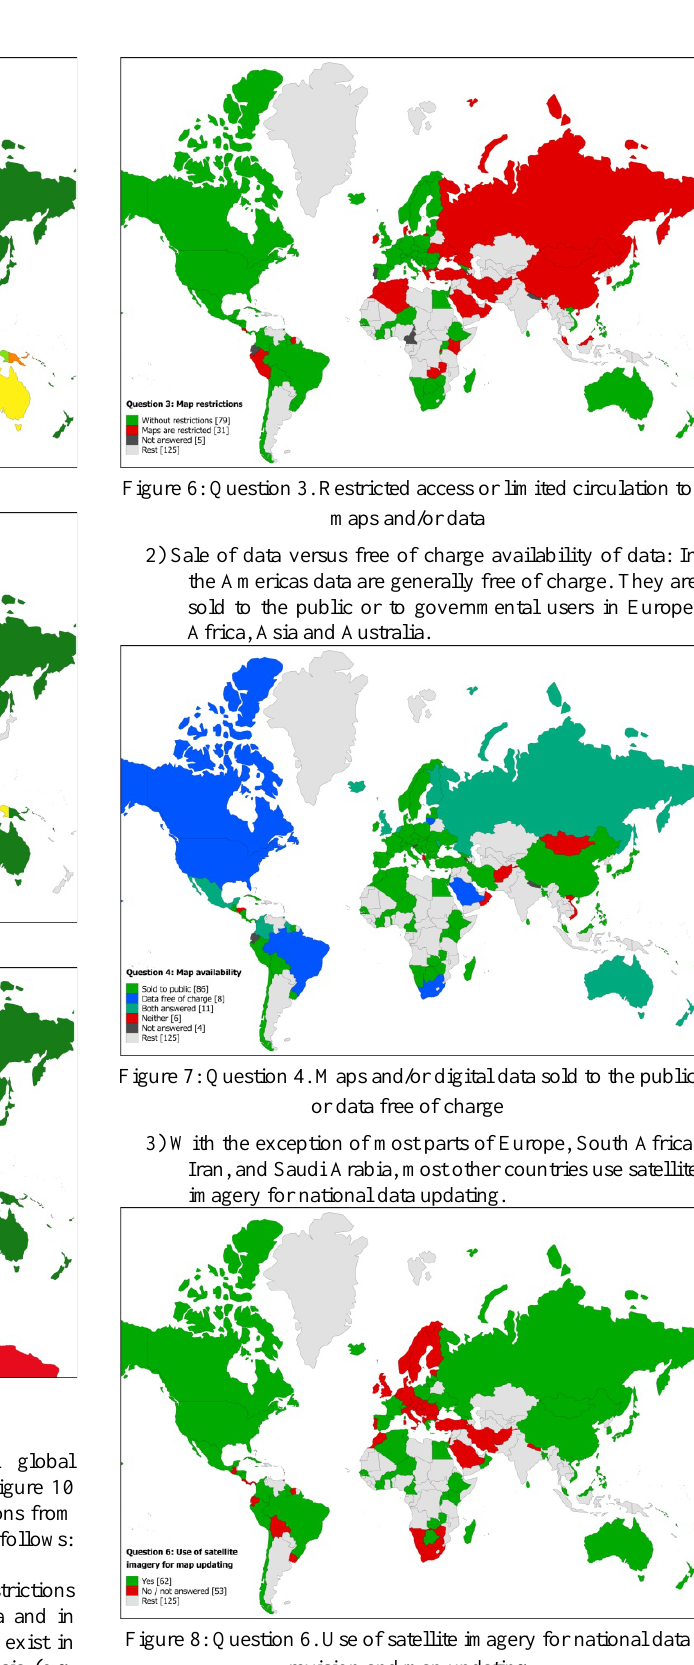
Figure 8: Question 6. Use of satellite imagery for national